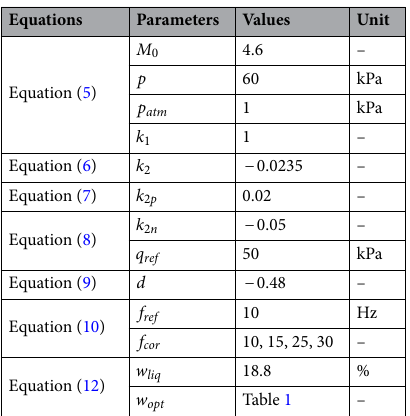
Table 4. Summary of regression coefficients of proposed resilient modulus rate dependent model.